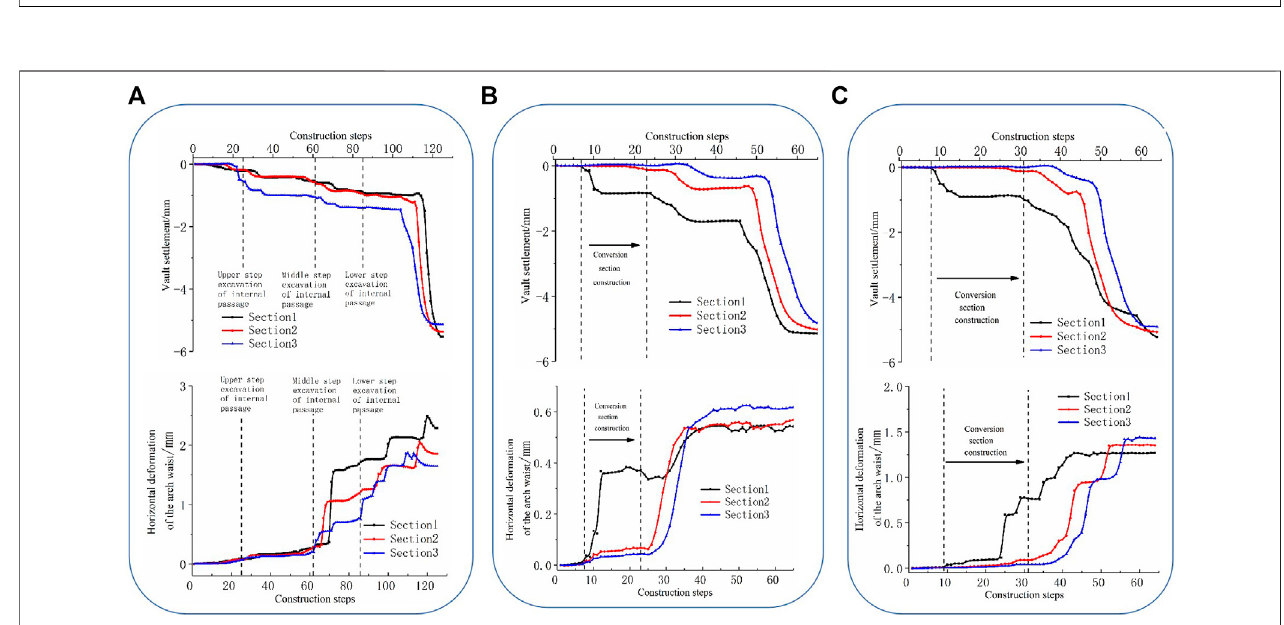
FIGURE 4 | Deformation curve of the supporting structure under each method (A) The double-holes interval pillar method, (B) the sector expansion method, and (C) the gate climbing method